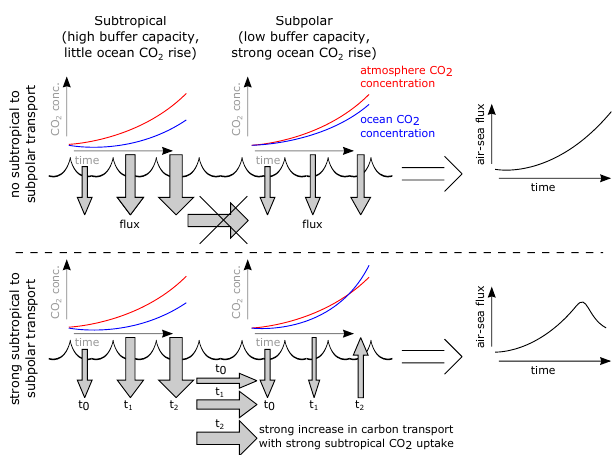
Figure 6. Diagrammatic explanation of the mechanism proposed in Völker at al. (2002) by which subpolar North Atlantic CO 2 con- centration may peak then decline in response to continuously rising atmospheric CO 2 concentrations. The top half of the diagram ex- plains what would happen if the low latitude and subpolar Atlantic were not connected by the circulation of the ocean (AMOC). Here, the higher alkalinity to dissolved-carbon ratio (the warm and saline low-latitude waters) of the subtropics means that these waters can strongly take up anthropogenic CO 2 without a big rise in surface ocean CO 2 concentrations. Similarly, the higher latitude subpolar waters (with low alkalinity to dissolved-carbon ratios) continuously take up CO 2 , but the (relatively) small buffering capacity of these waters means that the surface ocean CO 2 concentration rises (rela- tively) quickly. A smaller air–sea CO 2 gradient is therefore main- tained, and the air–sea CO 2 flux is (relatively) small. The bottom half of the diagram represents the situation in the real ocean, and the simulations considered in this study. Here the low latitude and subpolar Atlantic are linked by the near-surface limb of the Atlantic Meridional Overturning Circulation. In this situation, in response to rising atmospheric CO 2 , the low latitude CO 2 uptake continues (in our idealised example) as in the top half of the diagram, but some of that extra carbon is being moved into the subpolar Atlantic, where the buffering capacity is lower, and the water does not have the ca- pacity to hold as much extra carbon as CO 2 . This could ultimately result in the subpolar Atlantic becoming a source for anthropogenic CO 2 rather than a sink, as it may not have the capacity to hold the extra CO 2 being passed to it from the